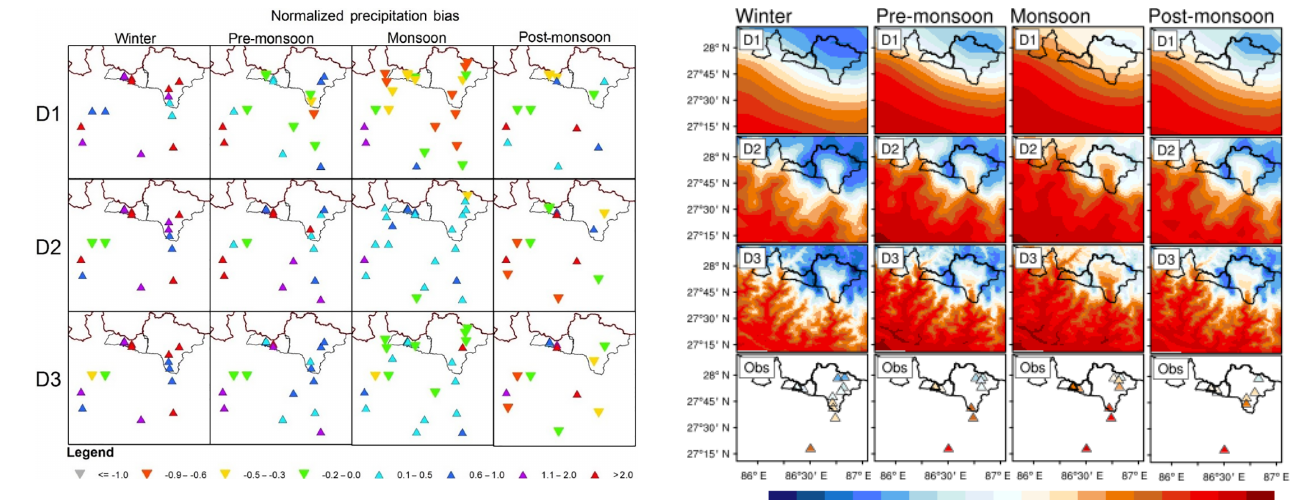
Figure 11. Station-wise normalized bias [(WRF–Obs) / Obs] of precipitation for three WRF resolutions for all four seasons zoomed over station location only.